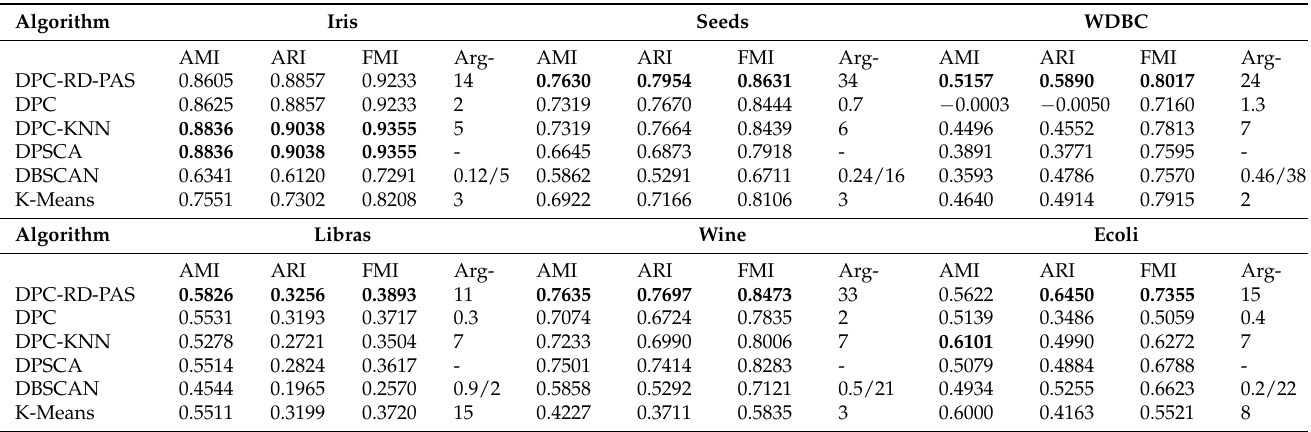
Table 4. Performance on UCI